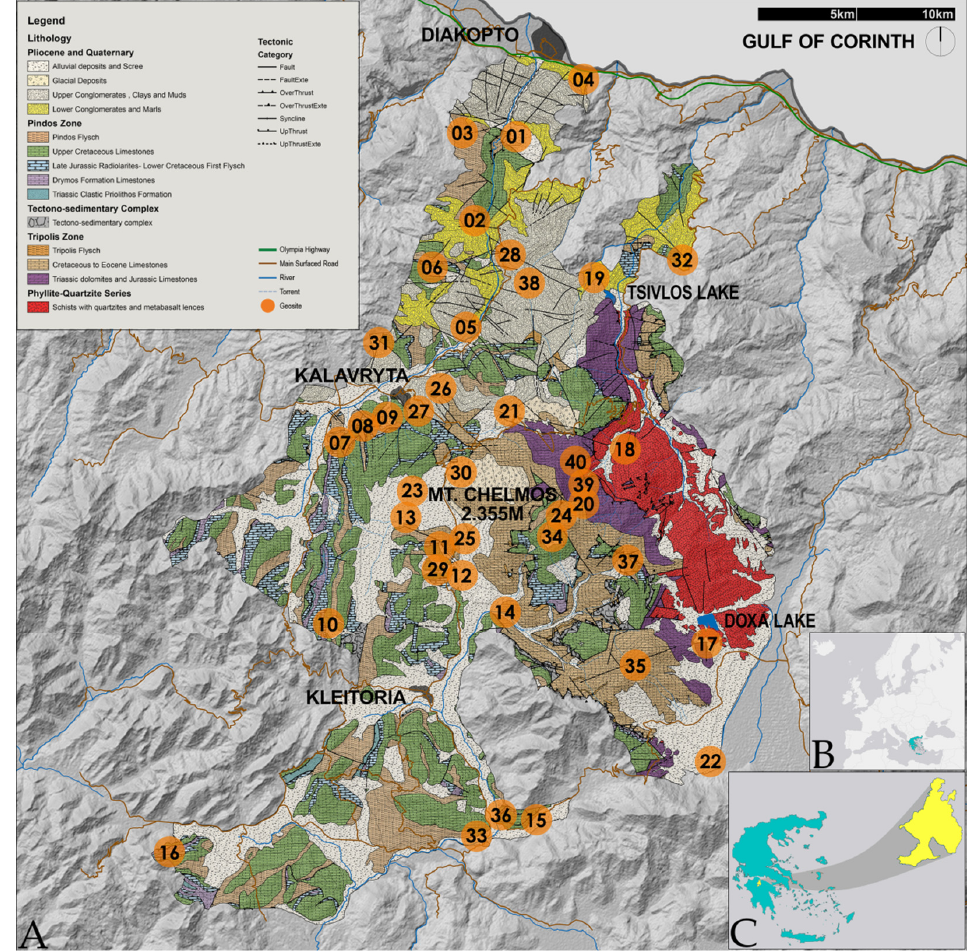
Figure 1. ( Α ) Geological map of Chelmos-Vouraikos UGGp with the locations of the geosites, ( Β ) Map of Europe indicating the position of Greece and ( C ) Map of Greece with the position of the study area.